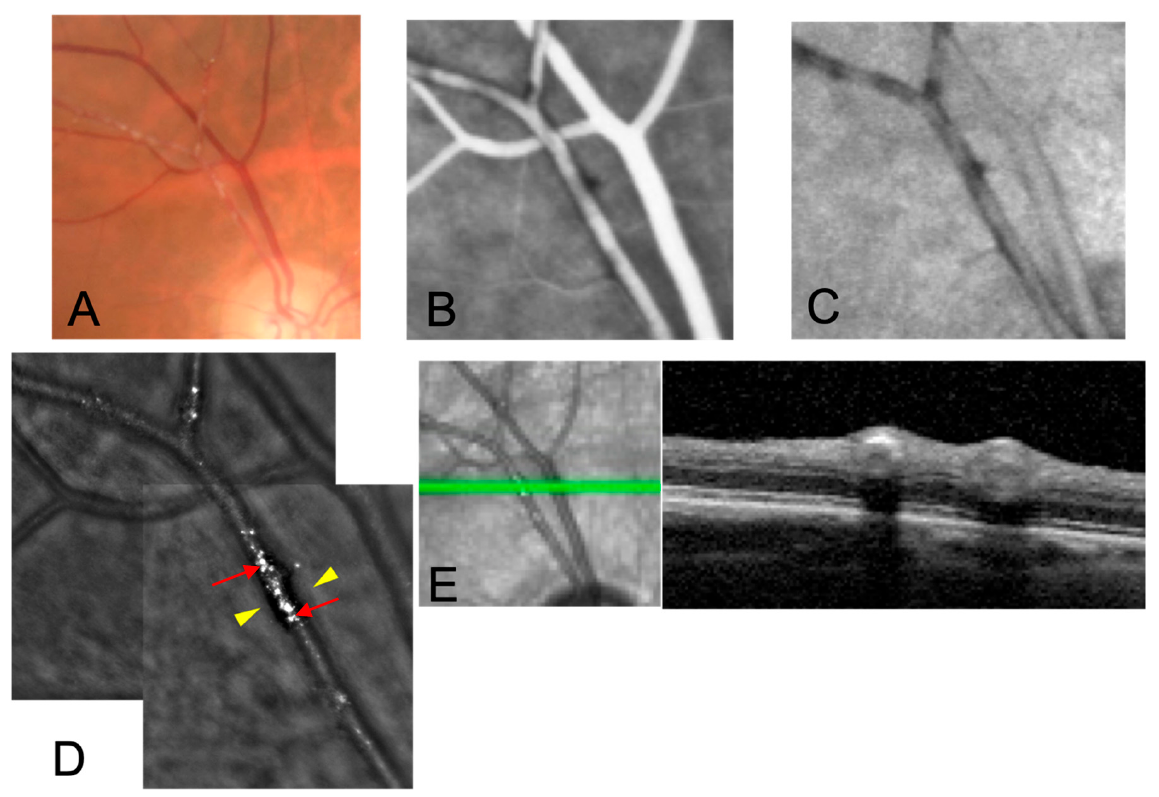
Figure 1. Multimodal imaging of case 1. A 78-yo man under steroid therapy for rheumatic polymyalgia developed VZV uveitis with arteritis and vitritis. RT-PCR confirmed the presence of viral genome in the aqueous humor (7,658,000 genomes/mL). He was treated with oral valacyclovir 2 g three times daily with good clinical improvement. ( A ) KP appear as whitish segmented deposits within the artery wall on FP; ( B ) late phase FA and ( C ) ICGA shows no leakage nor staining of the lesions; ( D ) AO imaging shows segmental arterial hyporeflectivity (yellow arrowheads) and adjacent granular hyperreflective spots on the vessel longitudinal axis (red arrows); ( E ) OCT scan shows hyperreflectivity of the arterial wall with underlying hyporeflective signal.